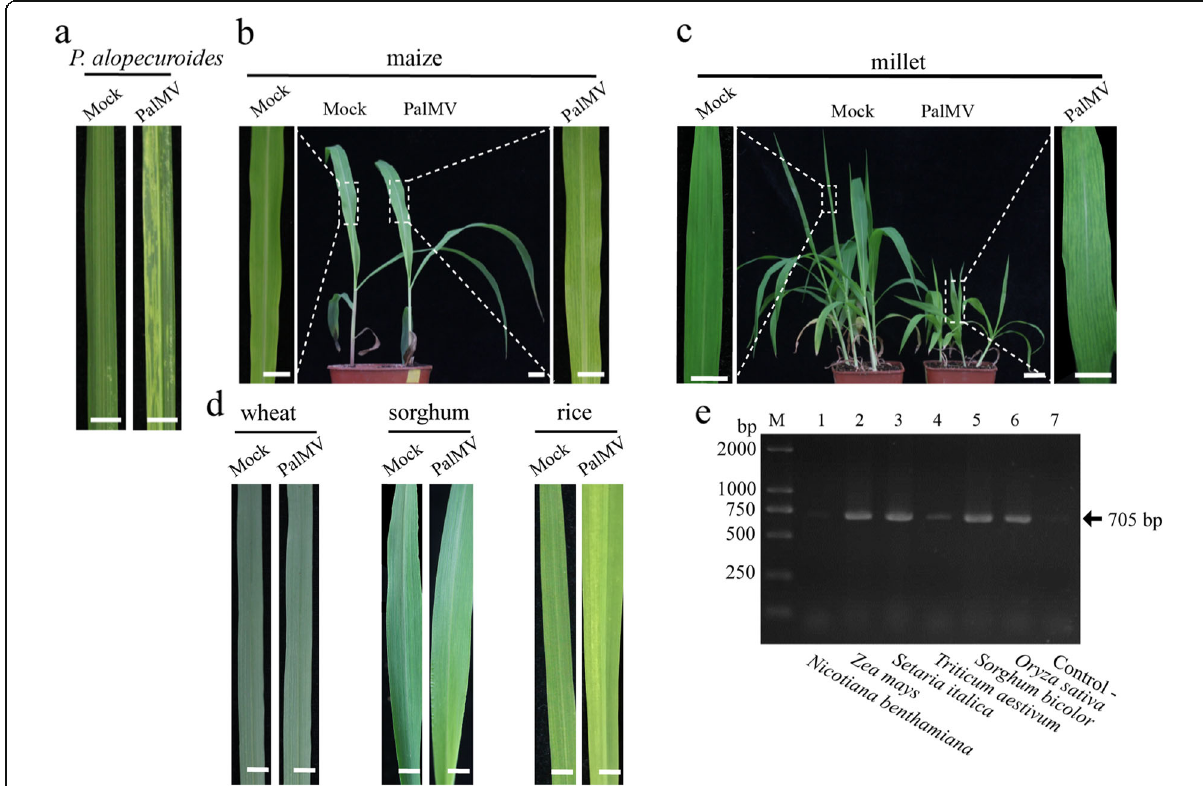
Fig. 5 Determination of systemic infection in inoculated plants by PalMV. a PalMV-inoculated P. alopecuroides plants displayed severe mosaic symptom on upper leaves, while the mock-inoculated plants were healthy. b PalMV-inoculated maize plants showed severe mosaic symptom in systemically infected leaves, while the mock-inoculated plants were healthy. c PalMV-inoculated millet plants showed a dwarfing phenotype and severe mosaic symptom on leaves. d Slight mosaic symptoms were observed on upper leaves of PalMV-inoculated wheat, sorghum, and rice plants. e Detection of PalMV by RT-PCR with the primer pair of CP-F and CP-R in inoculated plants. Lane M, DL2000 DNA ladder (TSINGKE, Beijing). Lanes 1 to 6 indicate PCR products amplified from infected leave samples of Nicotiana benthamiana , Zea mays , Setaria italica , Triticum aestivum , Sorghum bicolor and Oryza sativa , respectively. Lane 7, negative control. Leaves mechanically inoculated with phosphate buffer were used as negative control (Mock). Bars = 1